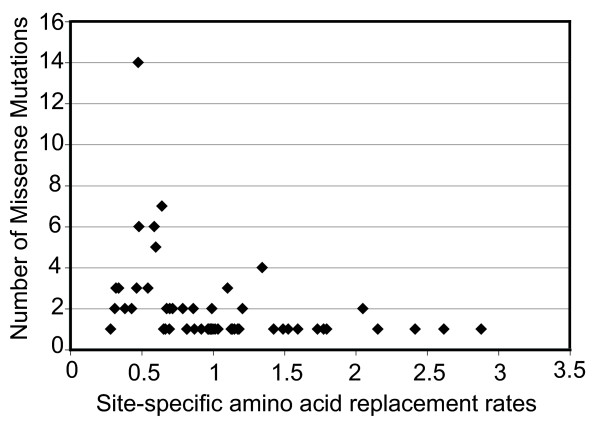
Correlation of the number of missense mutations versus the estimated site-specific amino acid replacement rate hosting the mutations.